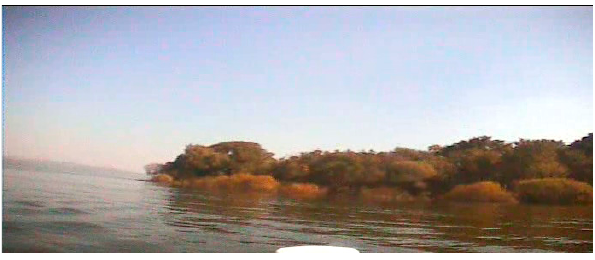
Figure 1. The image before structure extraction.